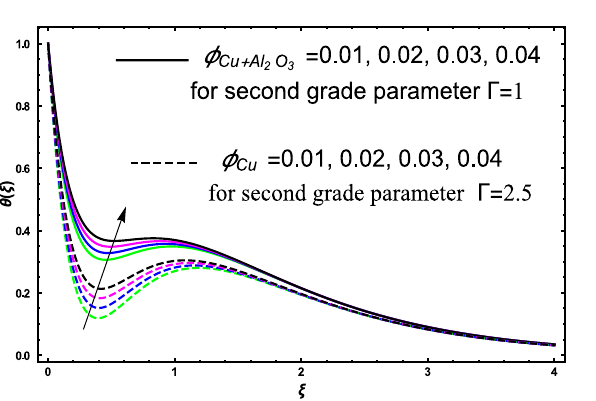
Figure 6. The fluctuation in temperature θ(ξ) profile against various values of φ Al 2 O 3 + Cu and φ Cu for different values of Ŵ